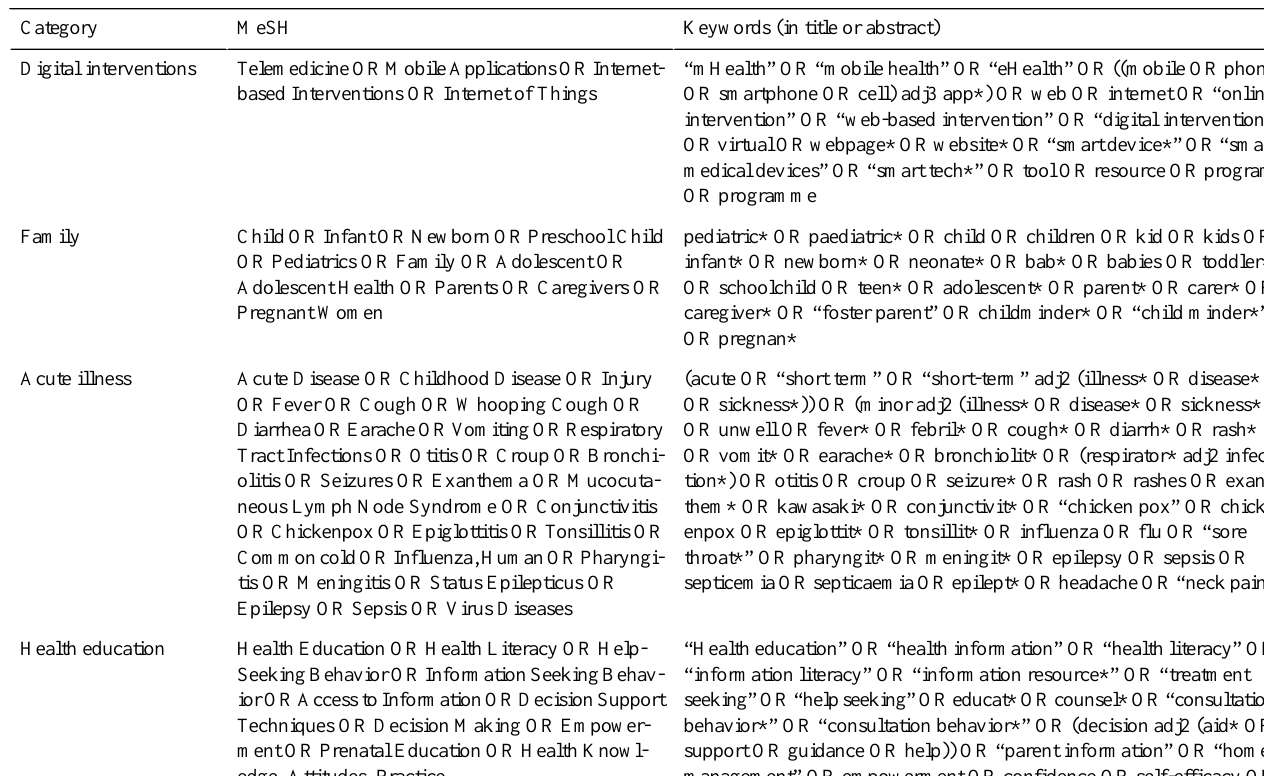
Table 2. Search terms.